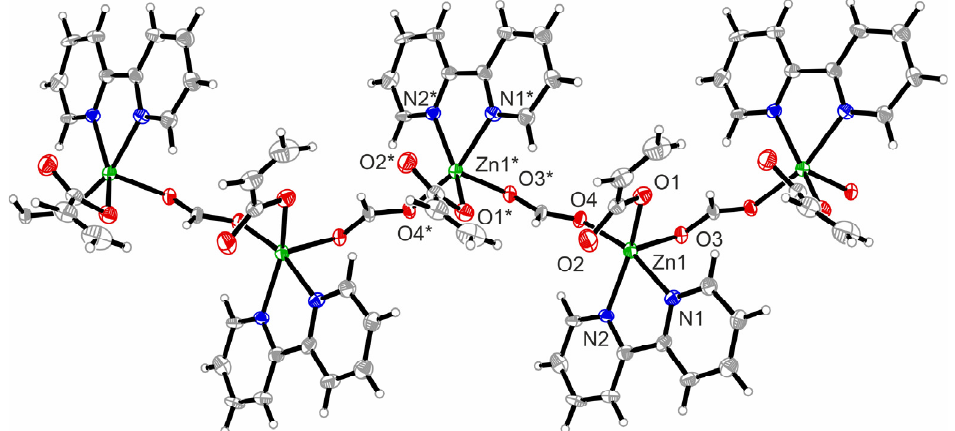
Figure 1. Crystal structure of polynuclear Zn(II) complex ( 1a ) (thermal ellipsoids are set at 30% probability; with * are represented the equivalent atoms generated by applying of the symmetry operator x+1/2, -y-1, z).